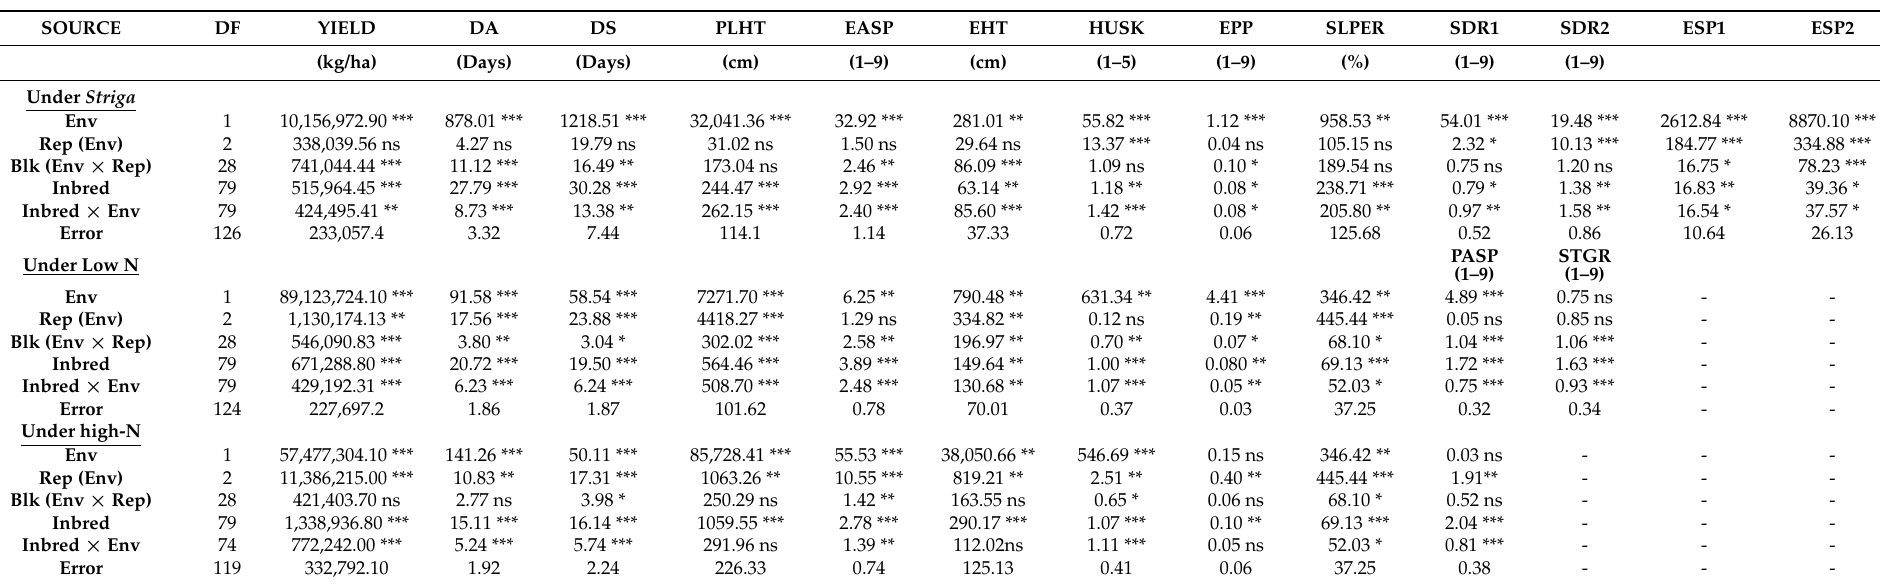
Table 3. Mean squares for grain yield and other agronomic traits of extra-early provitamin A quality protein maize inbreds evaluated under Striga , low-N and high-N environments at Abuja, Mokwa and Ile-Ife in Nigeria in 2016 and 2017.